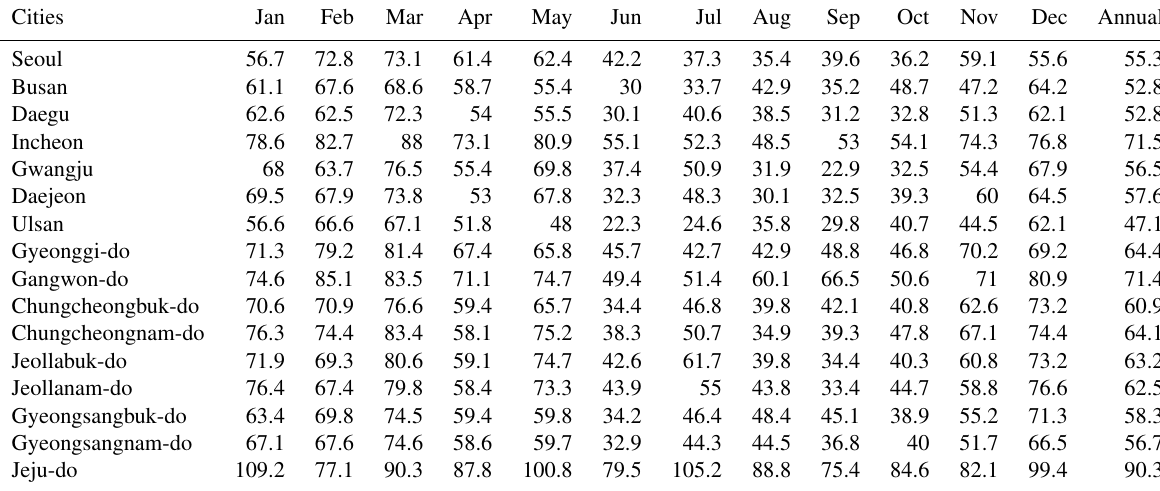
Table 5. Summary of foreign contributions (%) to surface PM concentrations for each month over major cities and provinces in South Korea using the WRF-CMAQ system. Cities